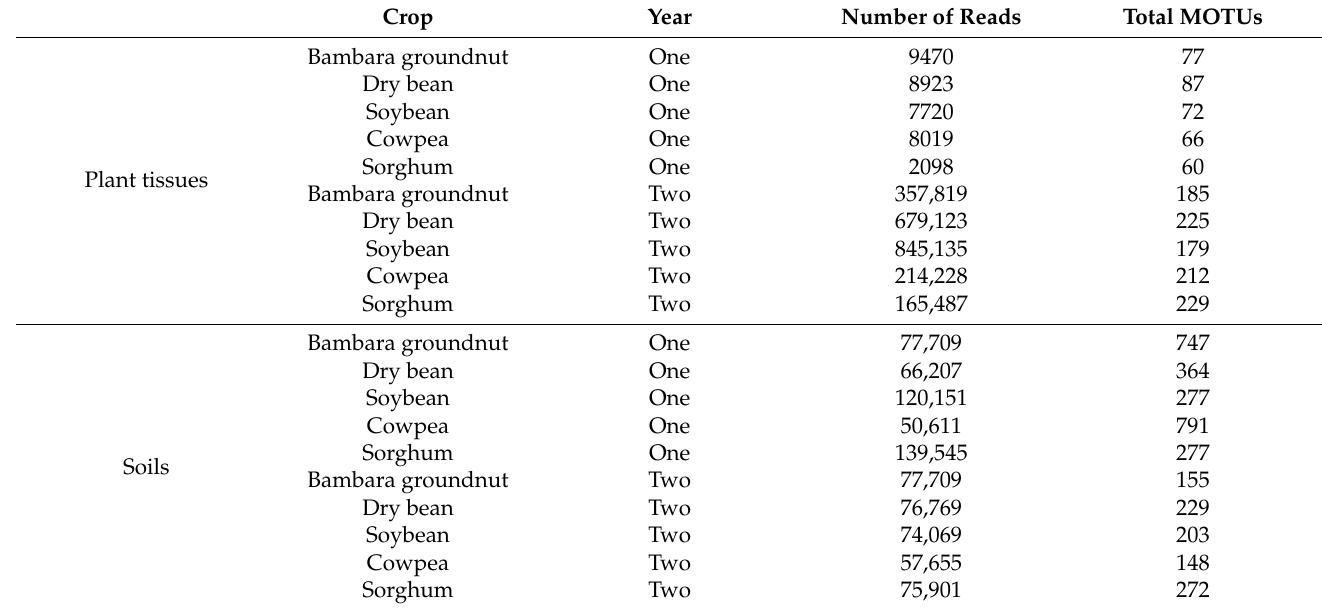
Table 1. Sequencing results and molecular operational taxonomic units (MOTUs) of plant tissues and soils for year one and two of a sorghum–legume intercrop system. Crop Year Number of Reads Total MOTUs